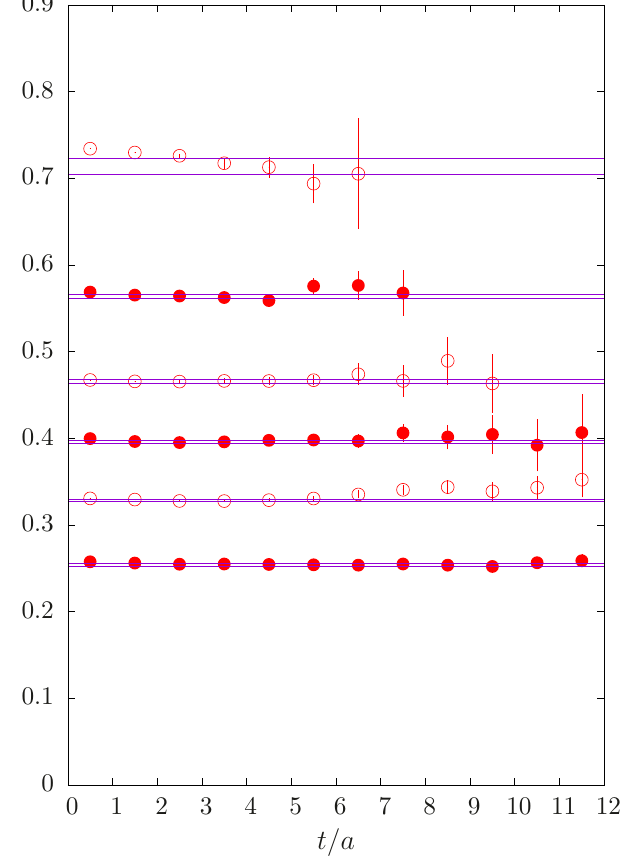
Figure 6 . E(cid:11)ective energies of the ground state traced string in SO(6) at (cid:12) = 46 : 0 for lengths l = 18 ; 22 ; 26 ; 30 ; 36 ; 46 in order. Pairs of lines are estimates.